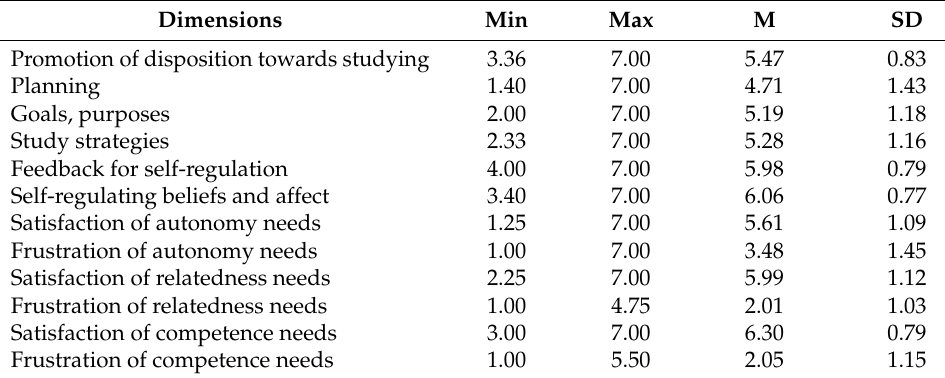
Table 1. Descriptive statistics of the studied